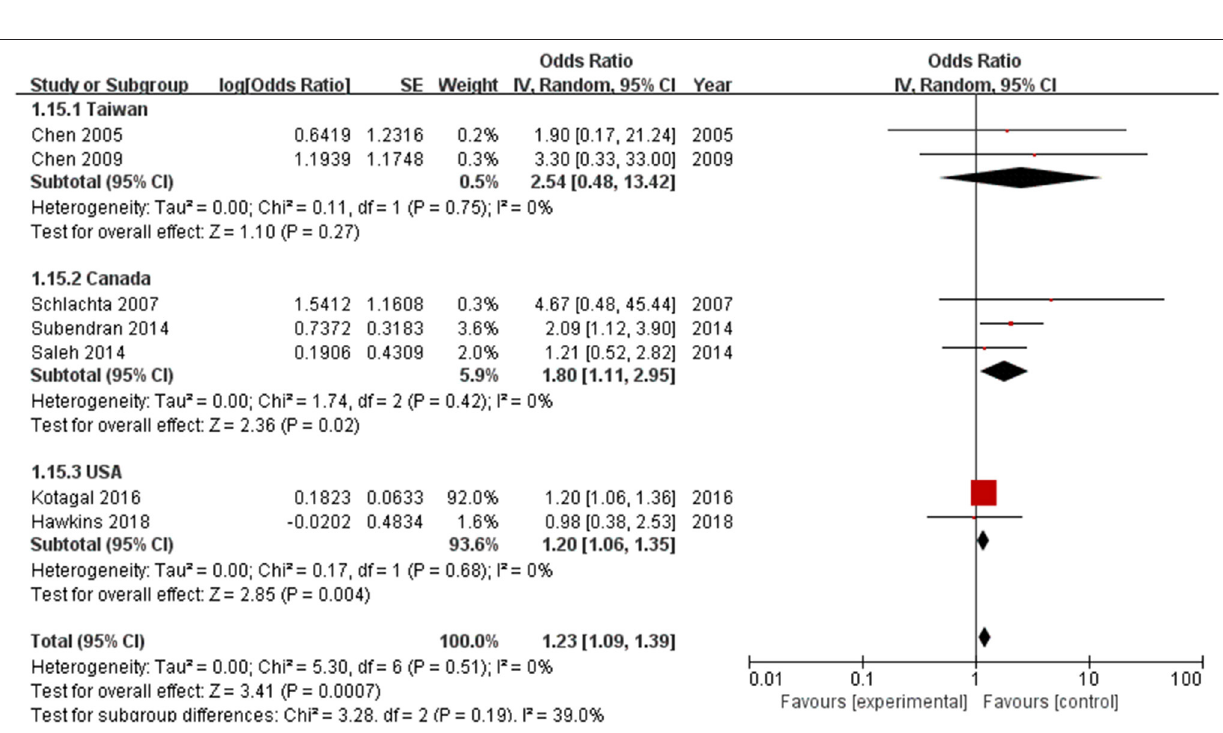
Frontiers in Surgery |